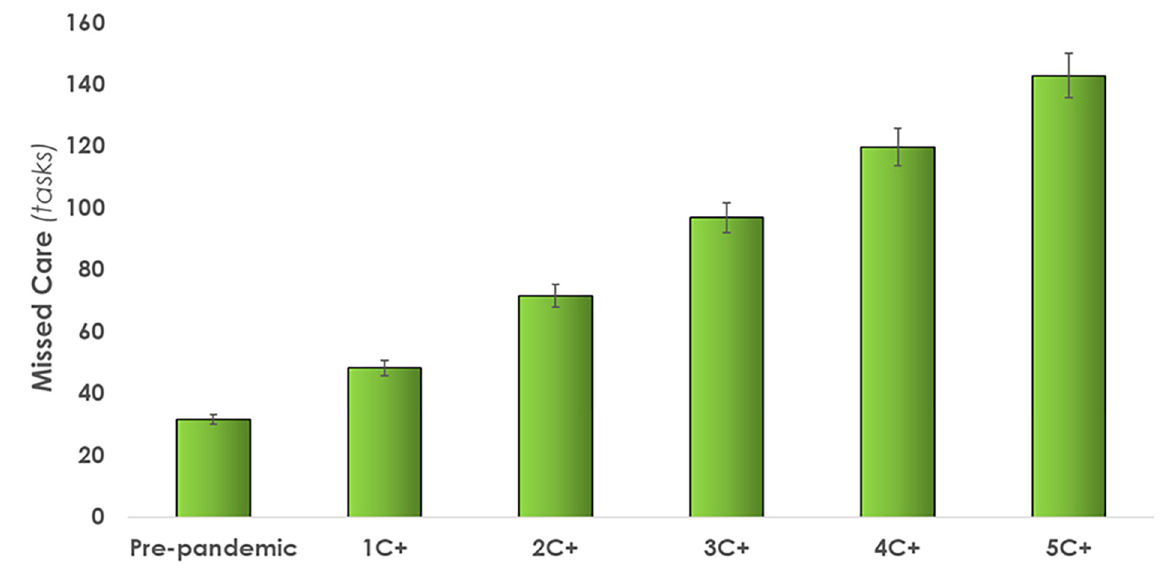
Fig 8. Average number of tasks missed when caring for one to five COVID-19 (C+) positive patients. Error bars indicate standard deviations. Table 3 provides a quantitative overview of the results.